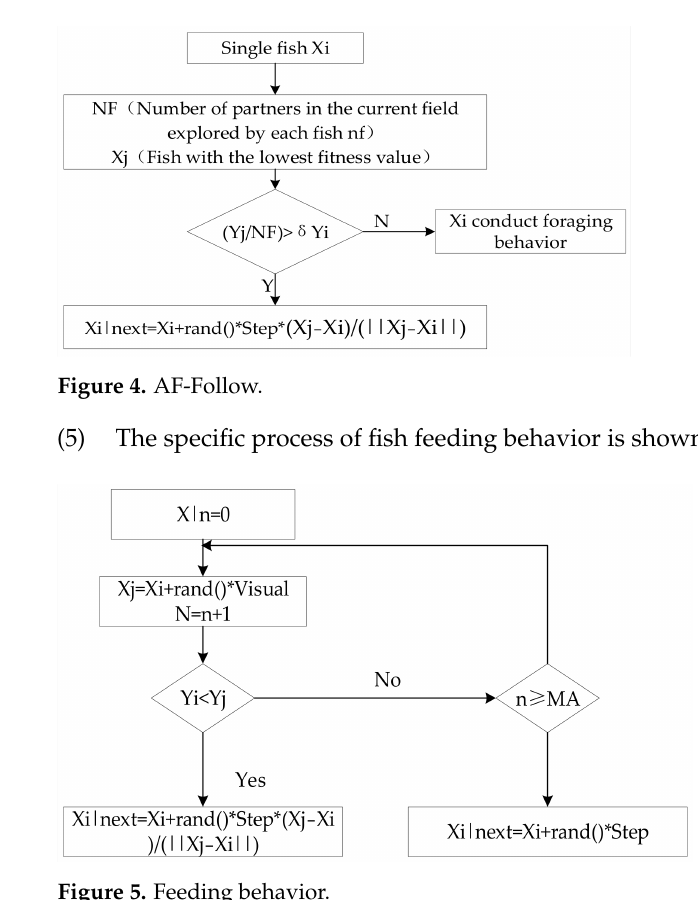
Figure 5. Feeding